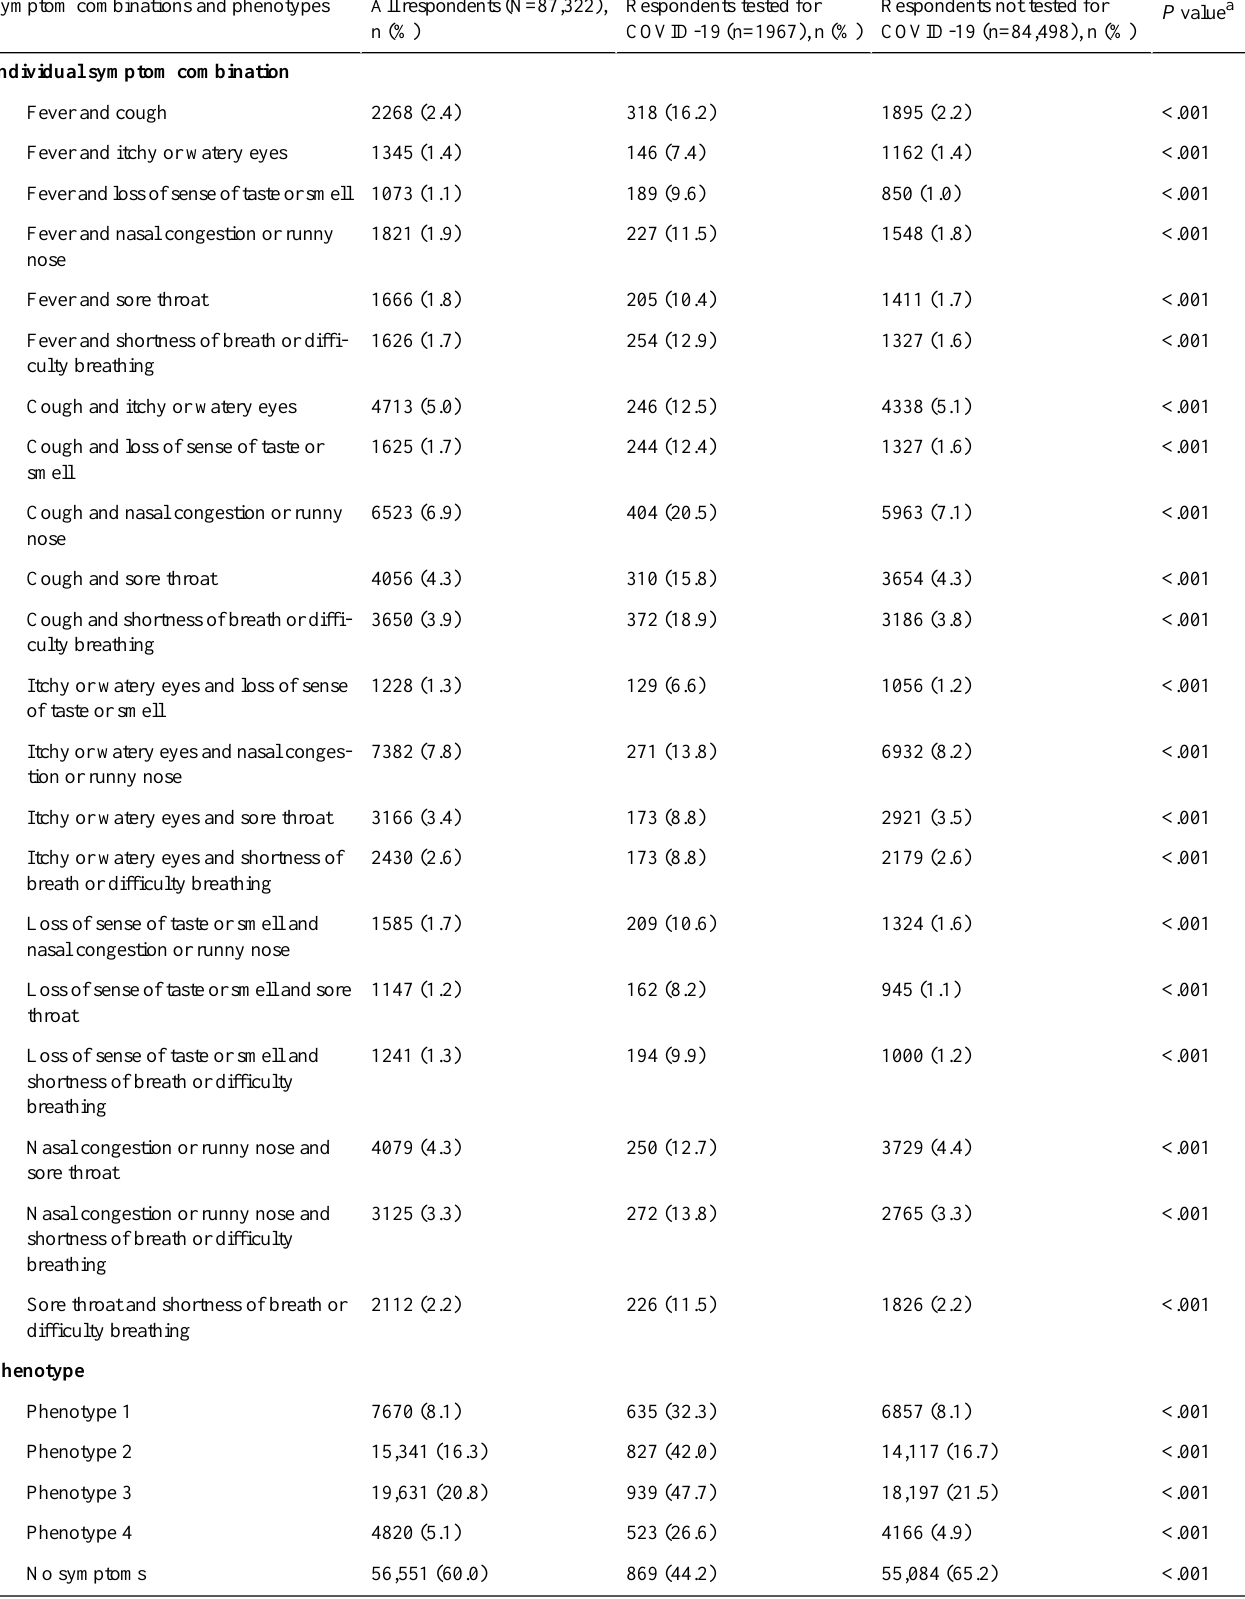
(%)Respondents tested for (%)All respondents (N=87,322), P value a Respondents not tested for COVID-19 (n=84,498), n COVID-19 (n=1967), n n